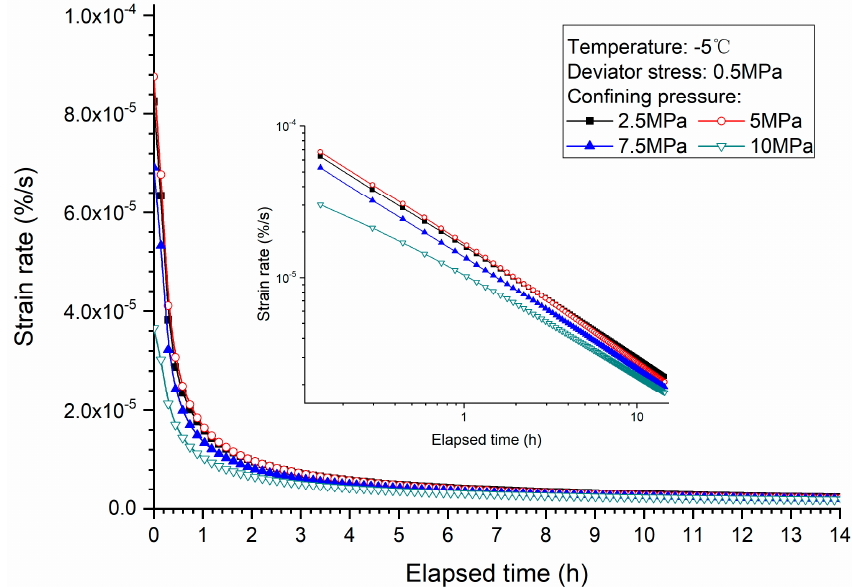
Figure 9. Creep strain rate versus elapsed time for methane hydrate-bearing frozen specimens under various confining pressure.